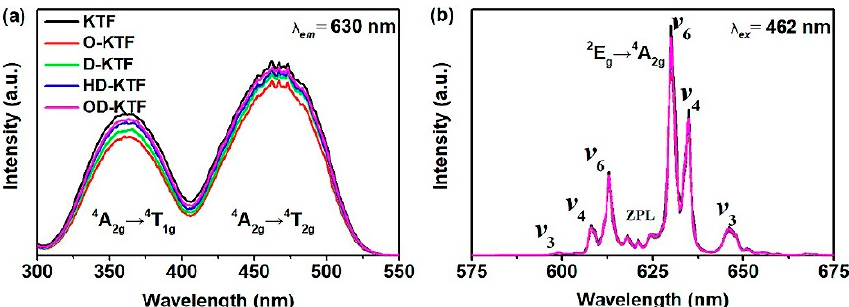
Figure 9. ( a ) Excitation and ( b ) emission spectra of K 2 TiF 6 after surface modification. (Reprinted from Ref [36]. Copyright from Elsevier, 2017).